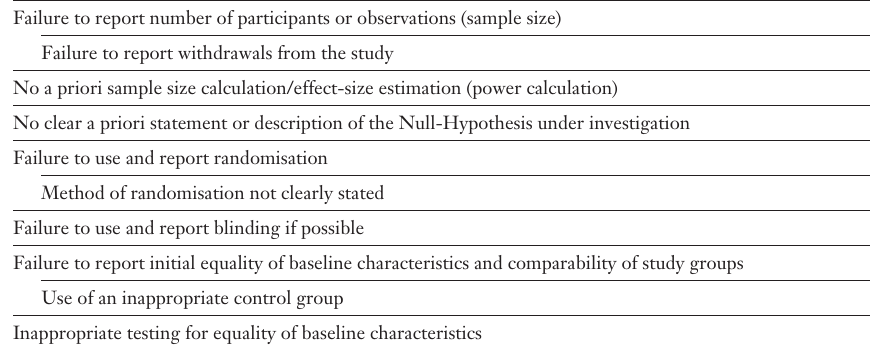
Statistical errors and deficiencies related to the design of a